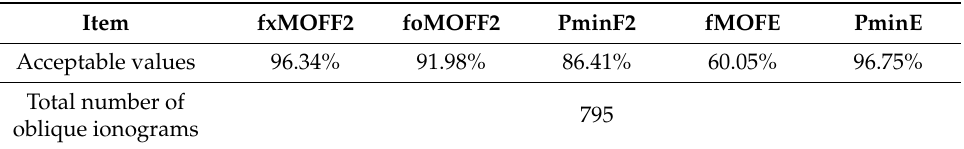
Figure 10. Similar to Figure 9, but for fMOFE and PminE. Table 1. The percentages of error statistical distributions of autoscaled parameters from oblique